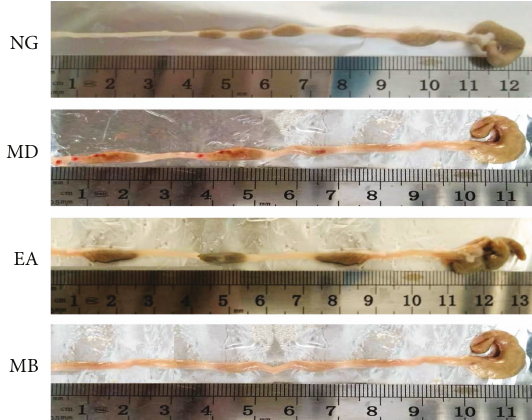
Figure 2: Appearance and morphology of the colon were observed in di ff erent groups. The NG showed normal intestinal appearance. The MD showed in fl ammatory intestinal appearance, and hyperemia, edema, and tissue necrosis were observed in distal colonic tissues. The EA and MB showed greatly improved appearance of the colon after receiving di ff erent treatments. NG: normal group; MD: model group; EA: electroacupuncture group; MB: moxibustion